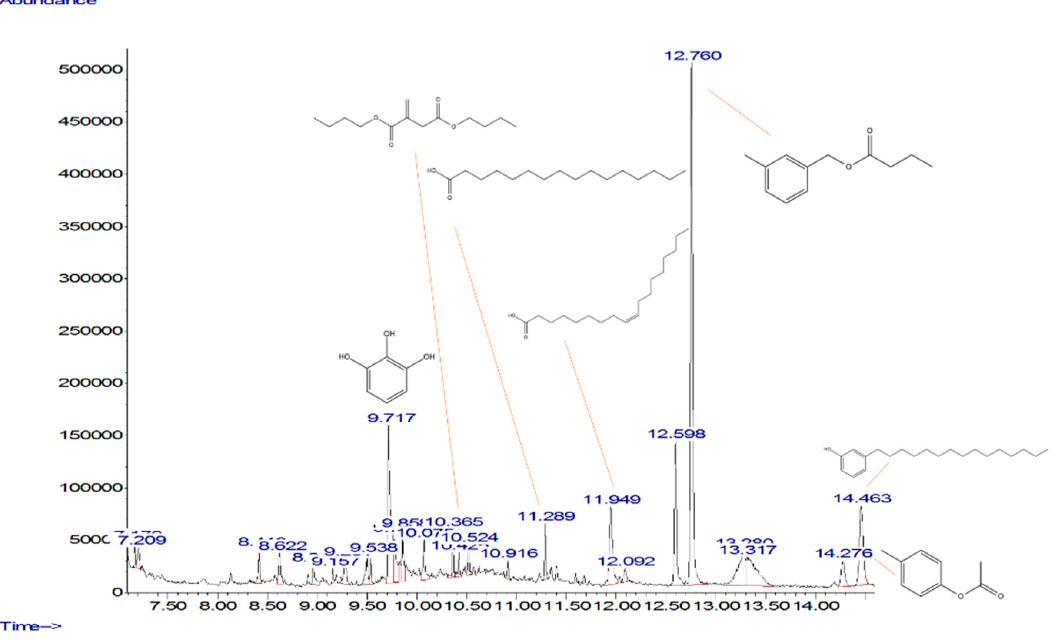
Figure A3. GC-MS chromatogram from MAW–pistachio hull.